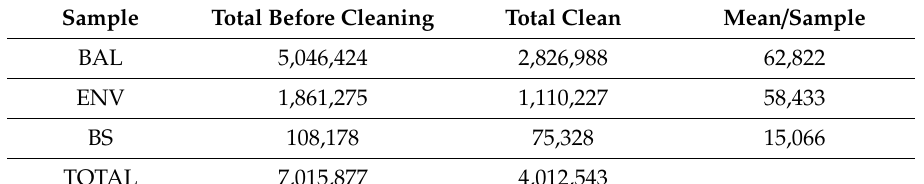
Table 2. Number of sequences by type of sample before and after cleaning.